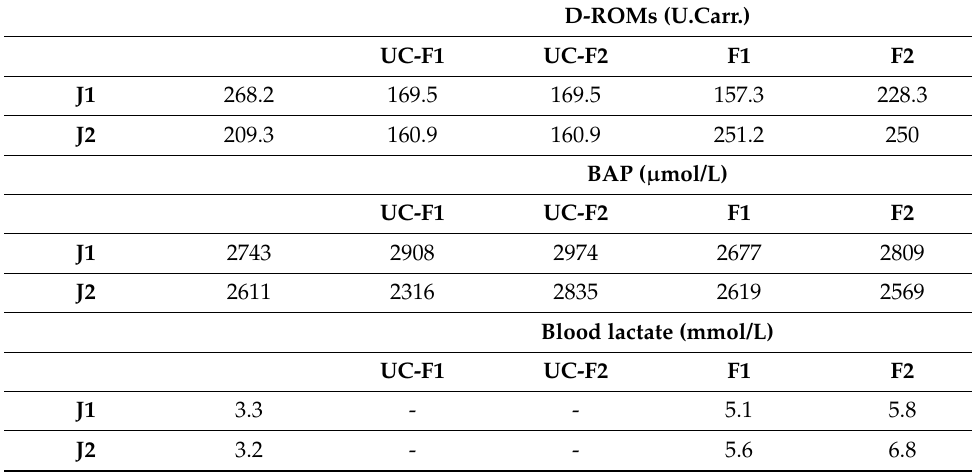
Table 2. d-ROMs and BAP concentrations in the dams, umbilical cords, and twin-foals, and blood lactate in twin-foals and their